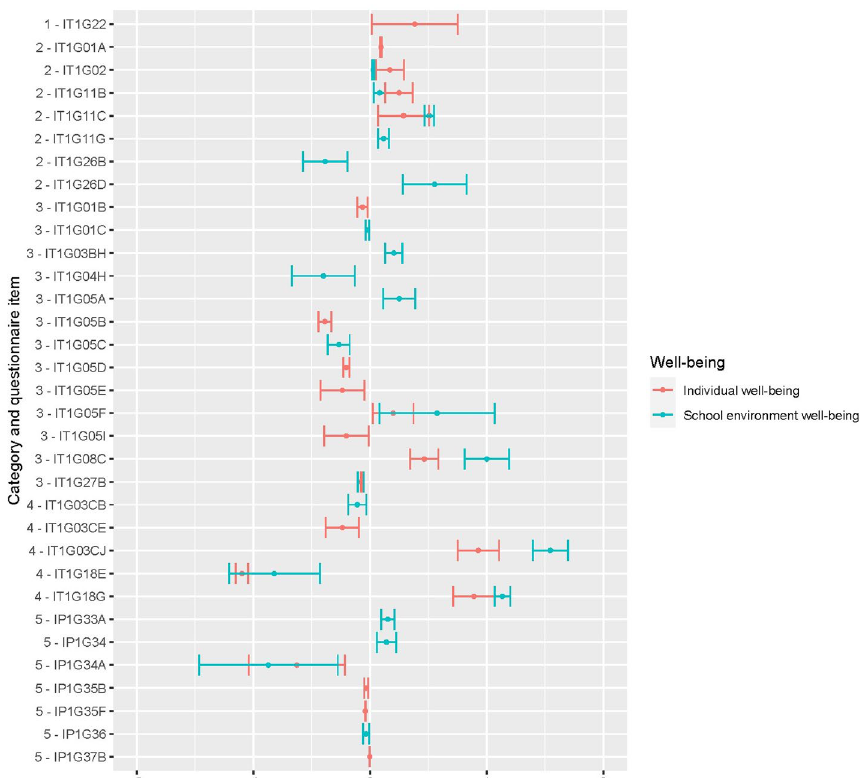
Fig. 1 Coefficients estimates of Mixed Effect Models. Categories: 01-Background, 02-Working characteristics, 03-Work (changing) conditions, 04-Covid-19 living conditions, 05-School